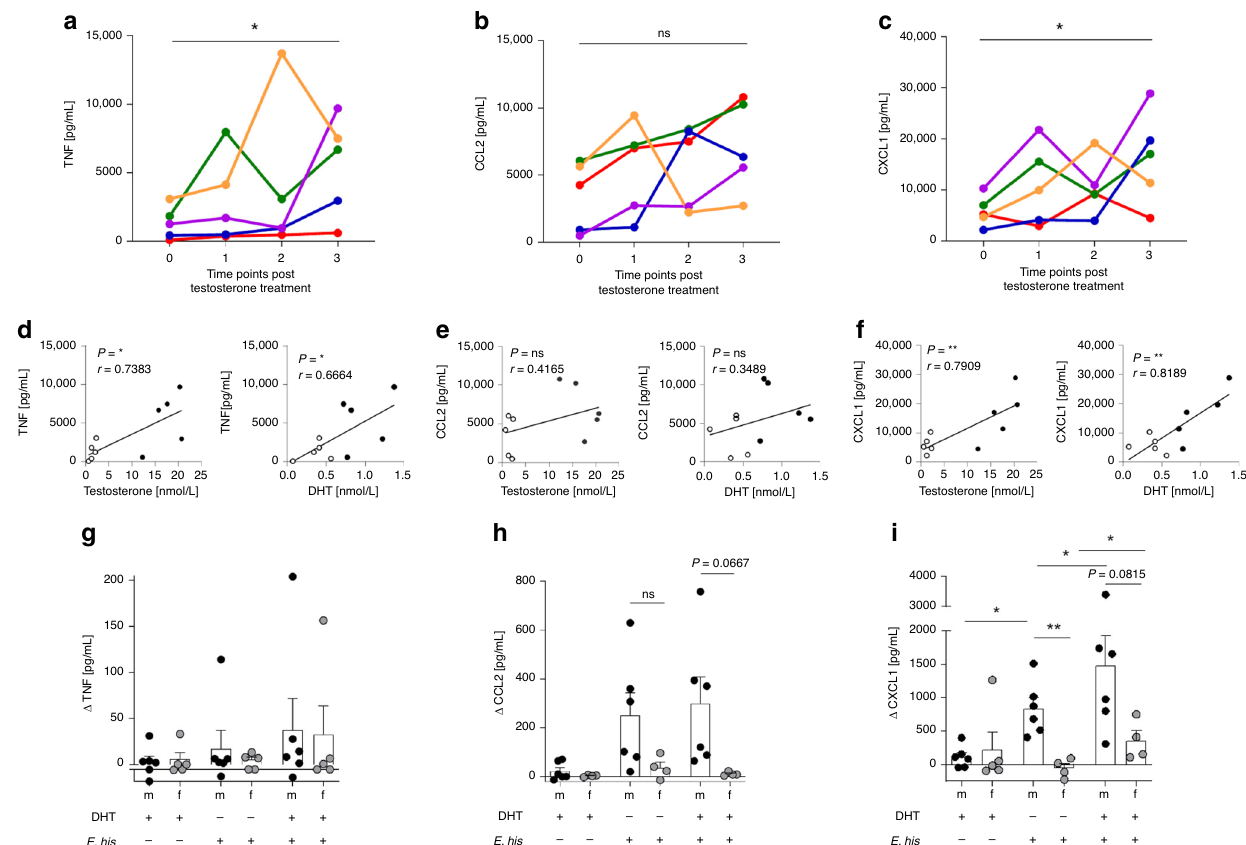
Fig. 6 Androgens modulates secretion of TNF and CXCL1 by PBMCs from transgender men. Cytokine production by LPS-stimulated PBMCs isolated from fi ve women transitioning to men under testosterone treatment. Women received testosterone intramuscularly, and PBMCs were collected at different time points from the start of hormone treatment (0 (Days − 9 – 0); 1 (Days 39 – 42); 2 (Days 112 – 126); and 3 (Days 201 – 219)) and stimulated with LPS (0.1 µ g/mL) for 17 h. Concentrations of a TNF, b CCL2, and c CXCL1 in the supernatant were measured using a Multiplex Cytokine Assay or ELISA (CCL2). Each donor is depicted in an individual color ( a n 0,1,2,3 = 5; b n 0,1,2,3 = 5; c n 0,1,2,3 = 5). Correlation between testosterone and 5 α -dihydrotestosterone (DHT) plasma levels in transgender men with d TNF, e CCL2, and f CXCL1 before transformation and at time point three post-transformation. Treatment of isolated peripheral, MACS-puri fi ed monocytes from healthy men and women with E. histolytica lysate (0.1 mg/mL) either alone or in the presence